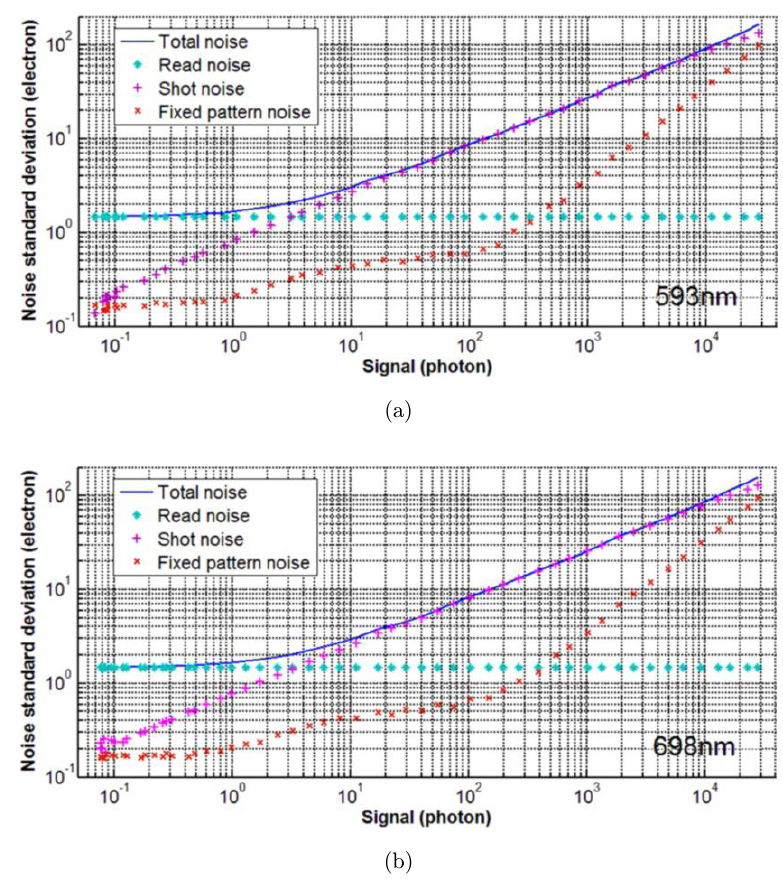
Fig. 3. The imaging performance of the same Hamamatsu Flash 4.0 sCMOS camera under two di®erent wavelengths. The PTC results for 593 nm (a) and 698 nm (b), and the corresponding rSNR curves (c). The reference lines in (c) indicate the rSNR curves of two hypothetical QE-limited cameras (QE ¼ 72% or 64%) which have only shot noise. The red arrow in (c) shows a gap in the rSNR curves which is caused by the use of two di®erent analog-to-digital converter. (d) The relative contributions of di®erent noises to the total noise. Here the percentage is de¯ned as the square of individual noise divided by the square of total noise. Note that the signal level below one photon means that there are only one photon occurred in several images, and that the rSNR of a hypothetical QE- limited camera equals to the square root of the QE of that